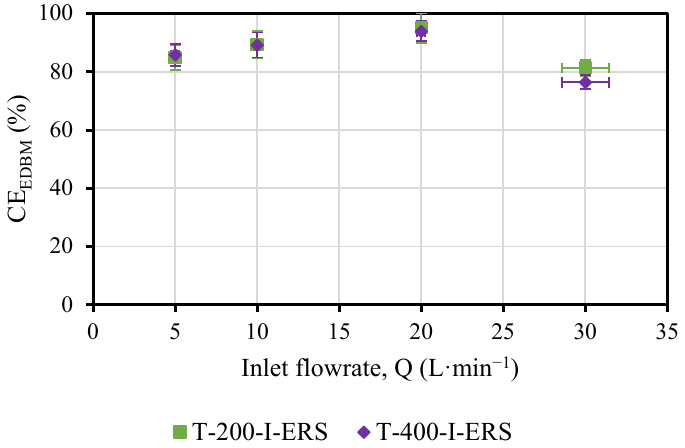
Figure 7. SEC EDBM versus the flowrate (Q) and as a function of the applied current density. ( a ) T ‐ 200 ‐ I ‐ ERS; ( b ) T ‐ 400 ‐ I ‐ ERS.